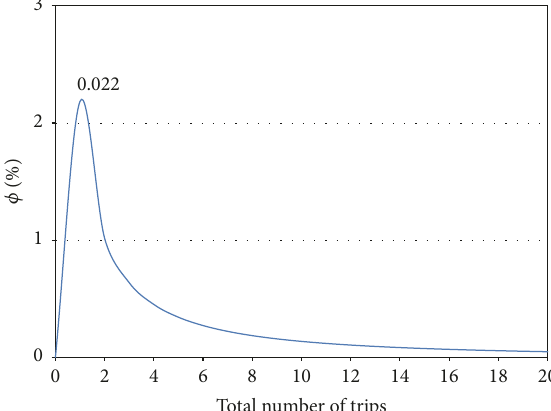
(∗) A weighting factor of unity indicates that the reference trip matrix used for the rush hour of each network was unchanged.